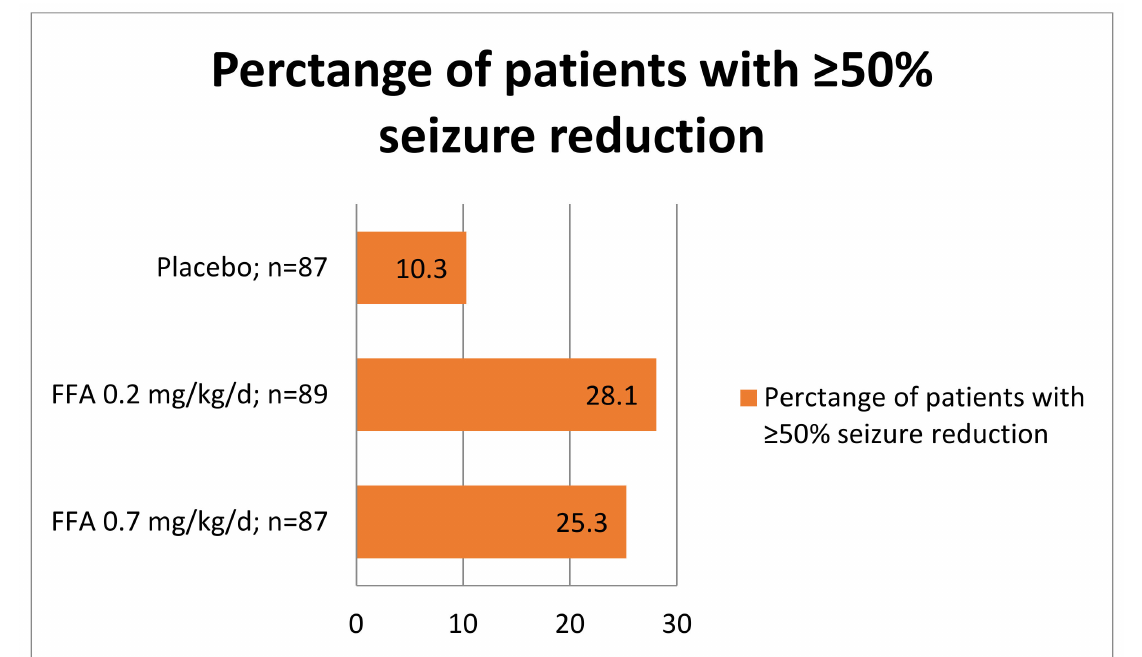
Figure 2. Median percent reduction from baseline in monthly drop seizure frequency and ≥ 50% seizure-responder rates as reported in the randomized controlled trial of fenfluramine in patients with Lennox–Gastaut syndrome [69]. p values with statistical comparison were documented in the